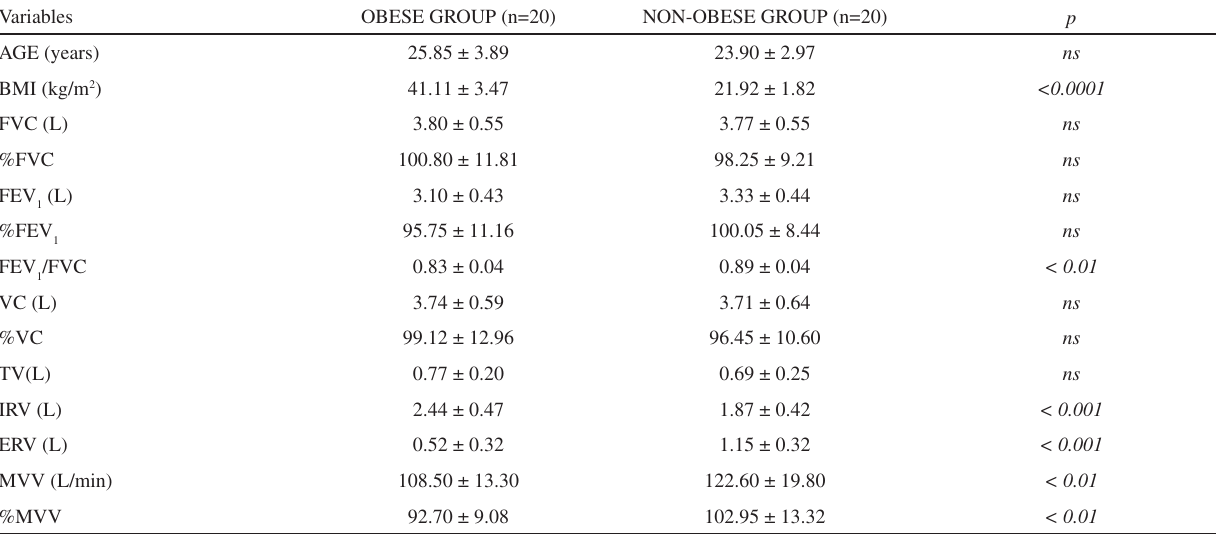
Table 1 - Age, body mass index (BMI), and spirometric variables of obese and non-obese groups Variables